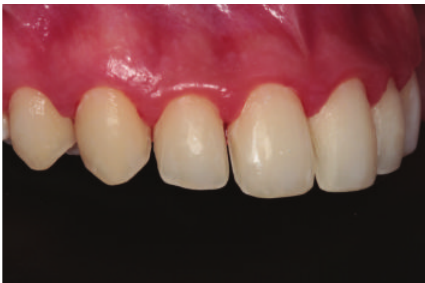
Figure 6: Teeth immediately after preparation. Note gum inflammation caused by the resins.